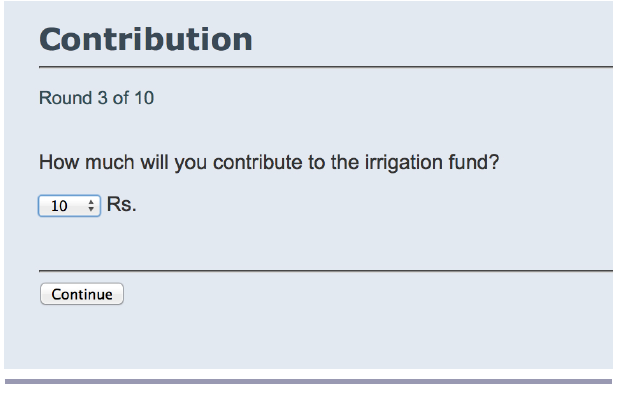
Fig. 3 . A screenshot of the GameWeb experimental environment when a public good is played.